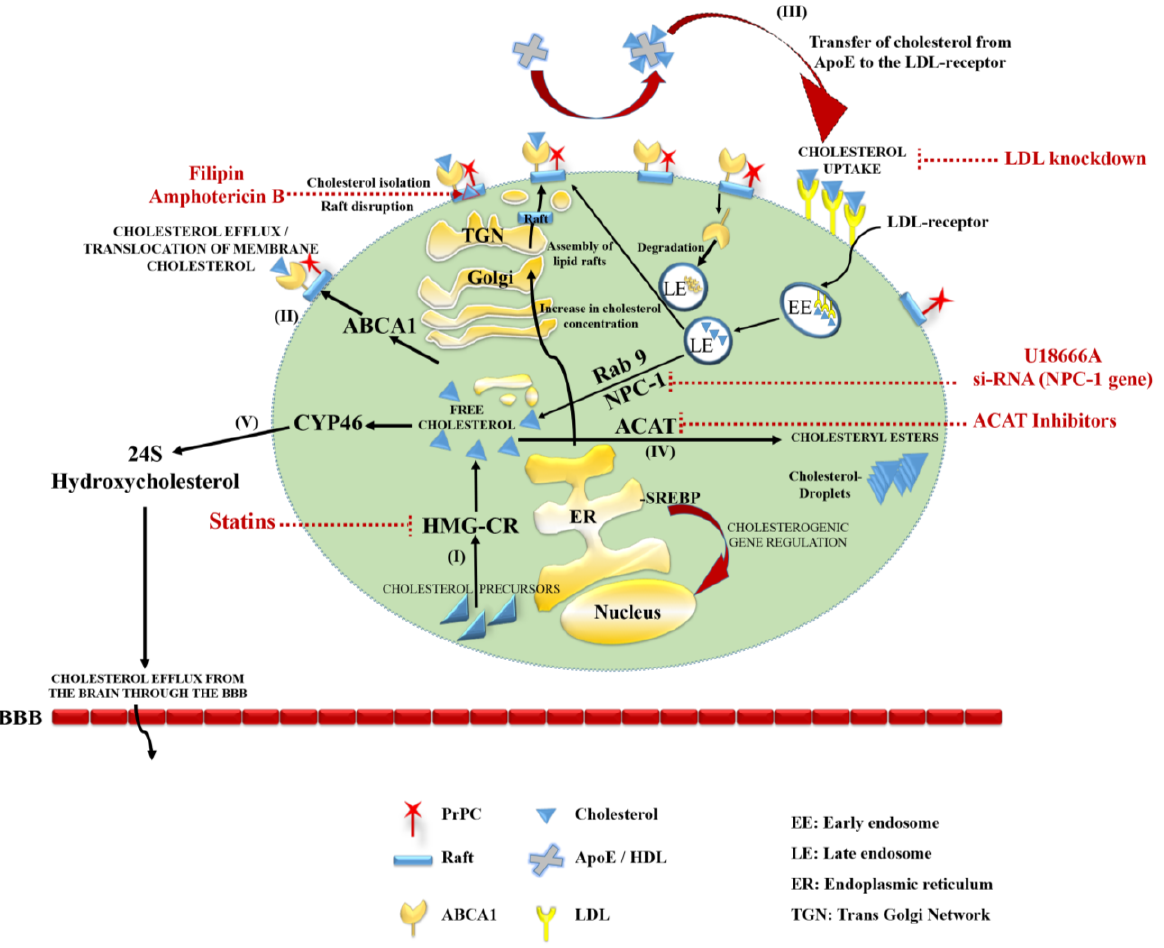
Figure 1. Cholesterol metabolism, lipid rafts and cellular prion propagation. (I) Cellular cholesterol, an essential component of lipid rafts, is synthesized from cholesterol precursors, with HMGCR as the rate limiting enzyme in the ER membrane; (II) Synthesized Cholesterol is secreted in an ABCA1 dependent process to form lipoprotein particles, or it is incorporated into membranes of the secretory pathway, where lipid rafts are assembled in the trans-Golgi network; (III) Uptake of extracellular cholesterol is mediated by ApoE/HDL interaction with the LDL-receptor. Cholesterol dissociates from the lipoprotein, is de-esterified and exported from late endosomes in a NPC protein dependent manner. It is then either transported to the plasma membrane or adds to the regulatory pool which prevents cleavage and nuclear translocation of SREBP. Once the capacity of cells to absorb cholesterol is exceeded, cholesterol is, in a small part, esterified by ACAT and accumulated as cytosolic lipid droplets (IV); The major pool of excess cholesterol is hydroxylated by CYP46 and converted to 24S-hydroxycholesterol, crosses the BBB and diffuses into the blood circulation (V). The red dotted lines represent examples for interference in cholesterol metabolism that resulted in a reduction or clearance of cellular PrP Sc